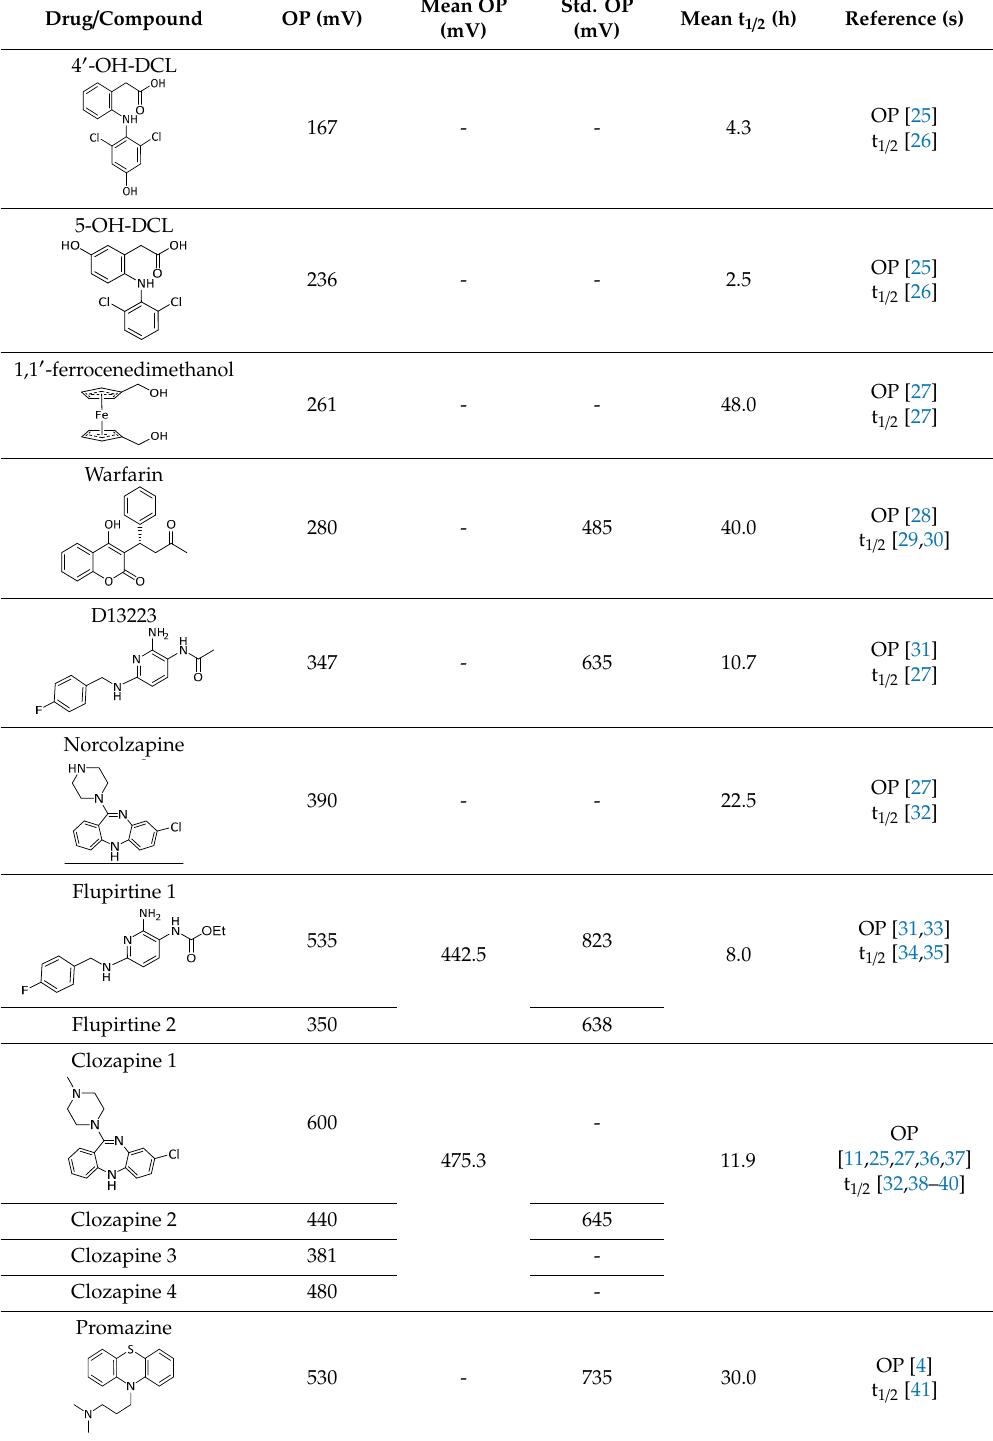
Table 1. Oxidation potential (OP) and half-life of identified compounds.